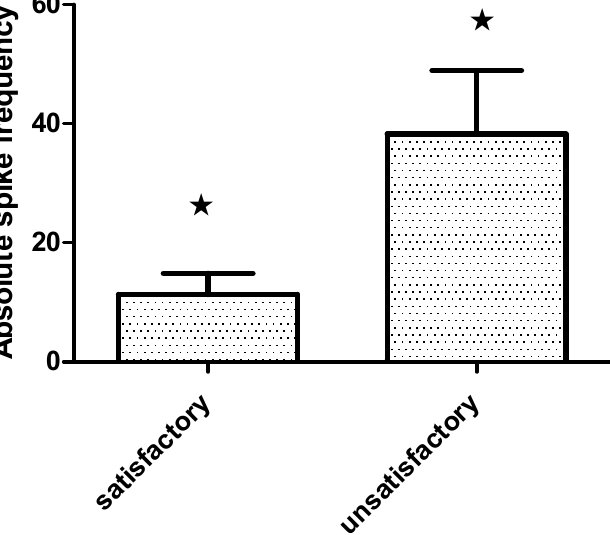
Figure 4. Bar grah showing absolute spike frequency on the pre-resection intraoperative Electrocorticography (ECoG) ( mean and standard error SE) in extratemporal epilepsies patients with satisfactory (Engel class I-II) and unsatisfactory (Engel class III-IV) outcome one year after surgery (Mann Whitney U test, *p=0.005).